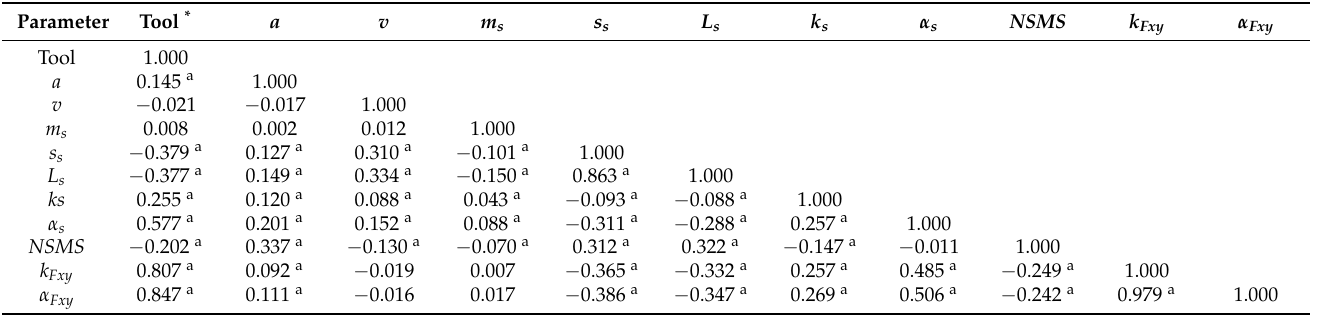
Table 6. The matrix of correlation coefficients for factors and parameters characterizing the movement of stones under the influence of forces of working